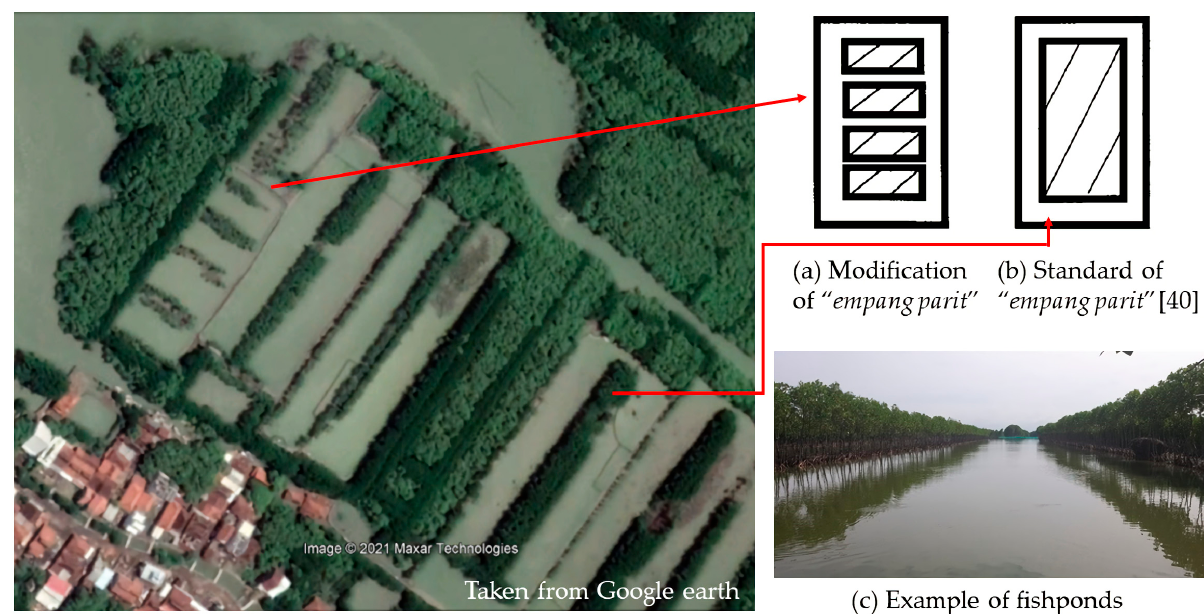
Figure 10. Silvofishery practices in Timbulsloko, which can be categorized as ( a ) modification of empang sari type and ( b ) empang sari standard, while ( c ) fishpond example in the study area.